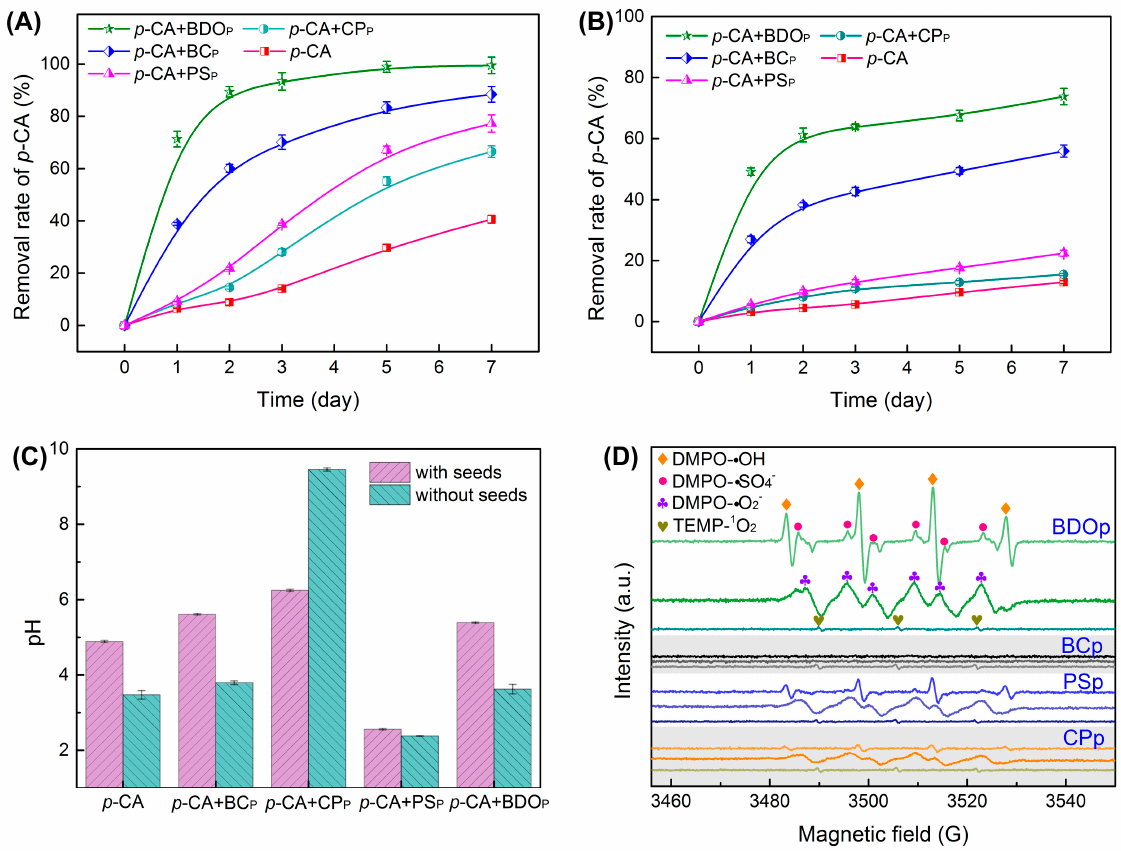
Figure 2. Evolution of the p -CA removal rate was determined under different treatments with tomato seeds ( A ) and without seeds ( B ). The pH value of the solution was measured under different treatments on the 7th day after culture ( C ). Results presented as the mean ± SD ( n = 4). ( D ) Electron paramagnetic resonance (EPR) spectra of reactive oxidizers with DMPO and TEMP after 10.0 min of reaction (Reaction conditions: 10 mL 400 mg/L p -CA; amount for BDO, BC, PS, and CP particles were 0.0375, 0.0250, 0.0098, and 0.0027 g, respectively; reaction temperature was 25 o C). Treatment